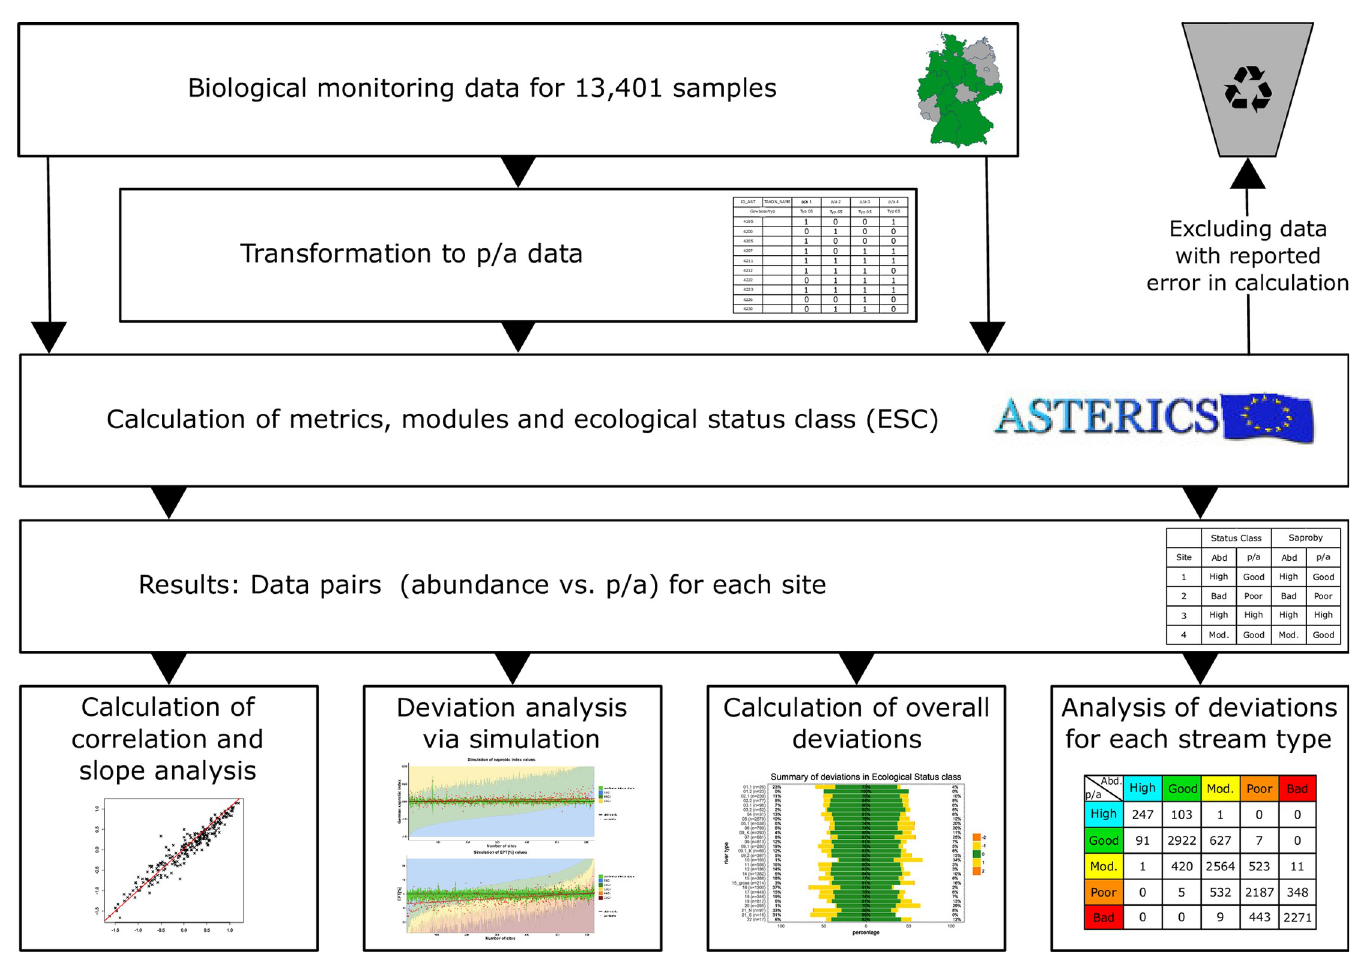
Fig 1. Overview of the study